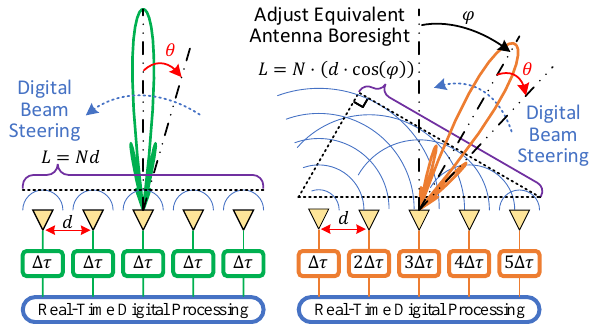
Figure 7. Diagram of the receiving beam control of the antenna.